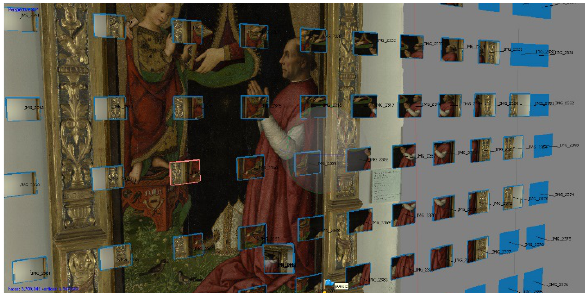
Figure 7 . Camera positions in front of the altarpiece